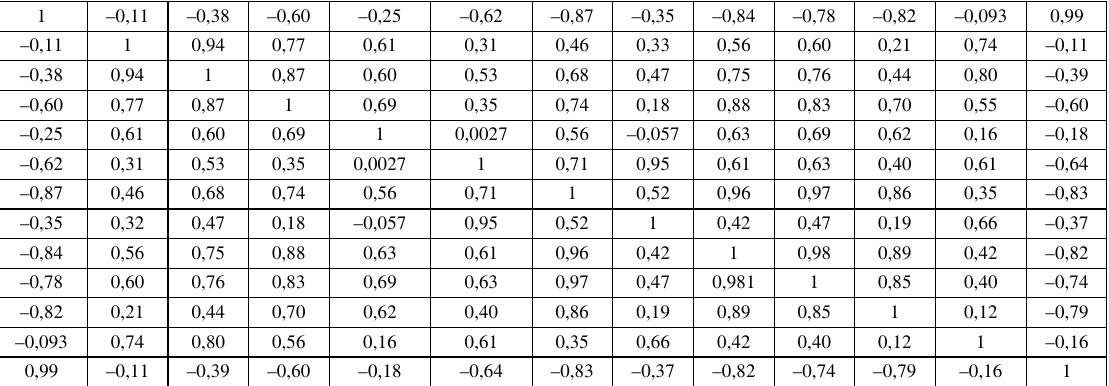
Table 3. Correlation coefficients according to test rig rotary table position (calculated every